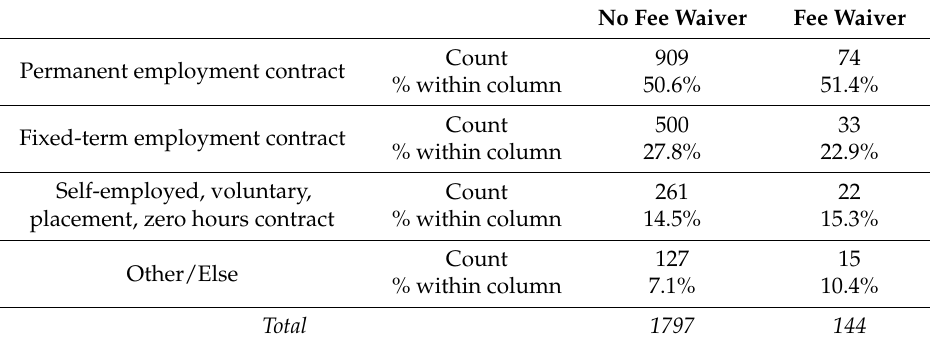
Table 2. Of those in employment: type of contract by fee waiver